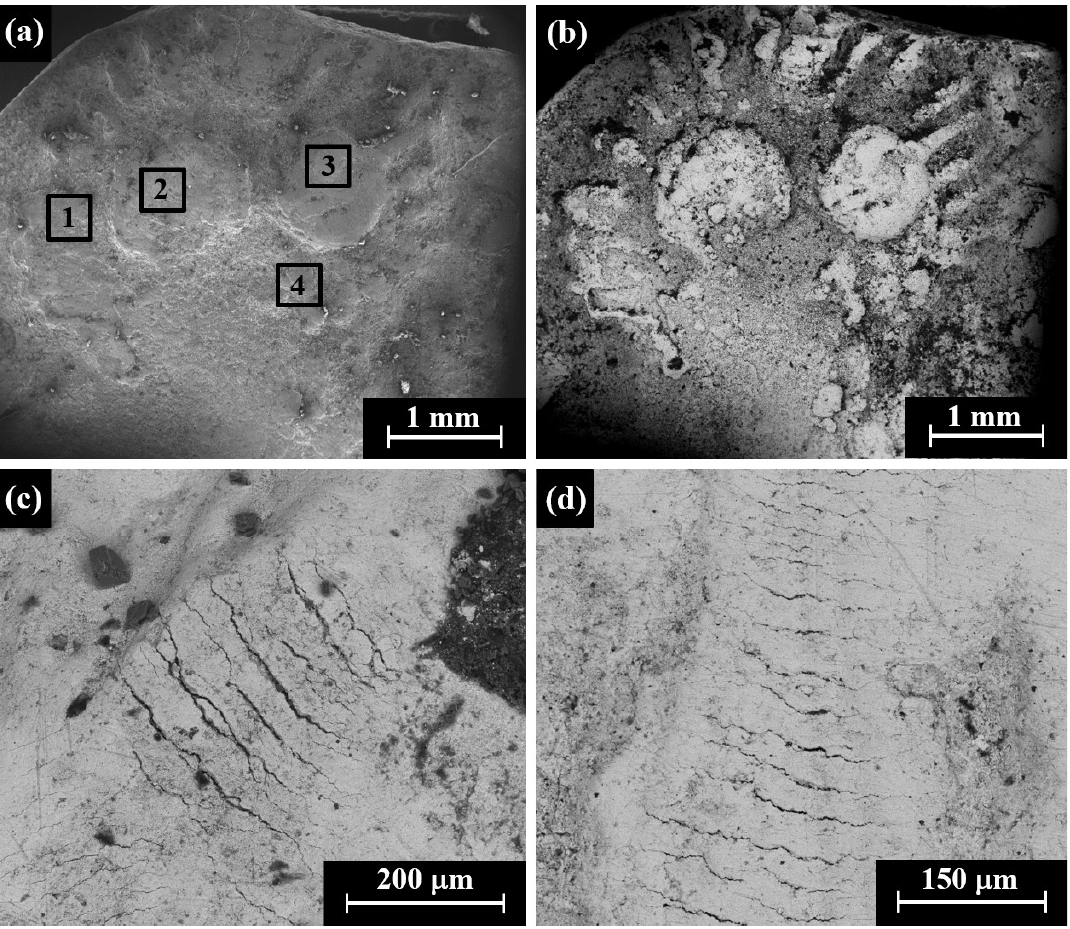
Figure 9. SEM images of the Yehud gerah Type 5 O1/R5 reverse side with the image of an owl: ( a ) coin IMJ 34558 (SE mode), where the areas inside the squares 1 – 4 were examined by EDS analysis; ( b ) coin IMJ 34558 (BSE mode); and ( c , d ) coin IMJ 27388 with parallel cracks.